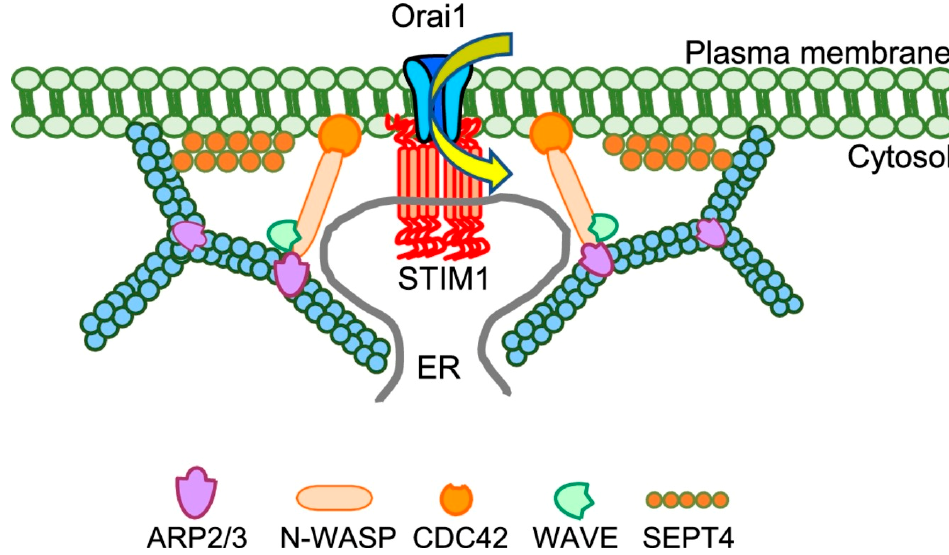
Figure 1. Cytoskeletal remodeling in ER-PM junctions. Remodeling of the actin cytoskeleton and septin filaments to enable formation and stabilization of ER-PM junctions populated by STIM1/Orai1 signaling complex [38] .